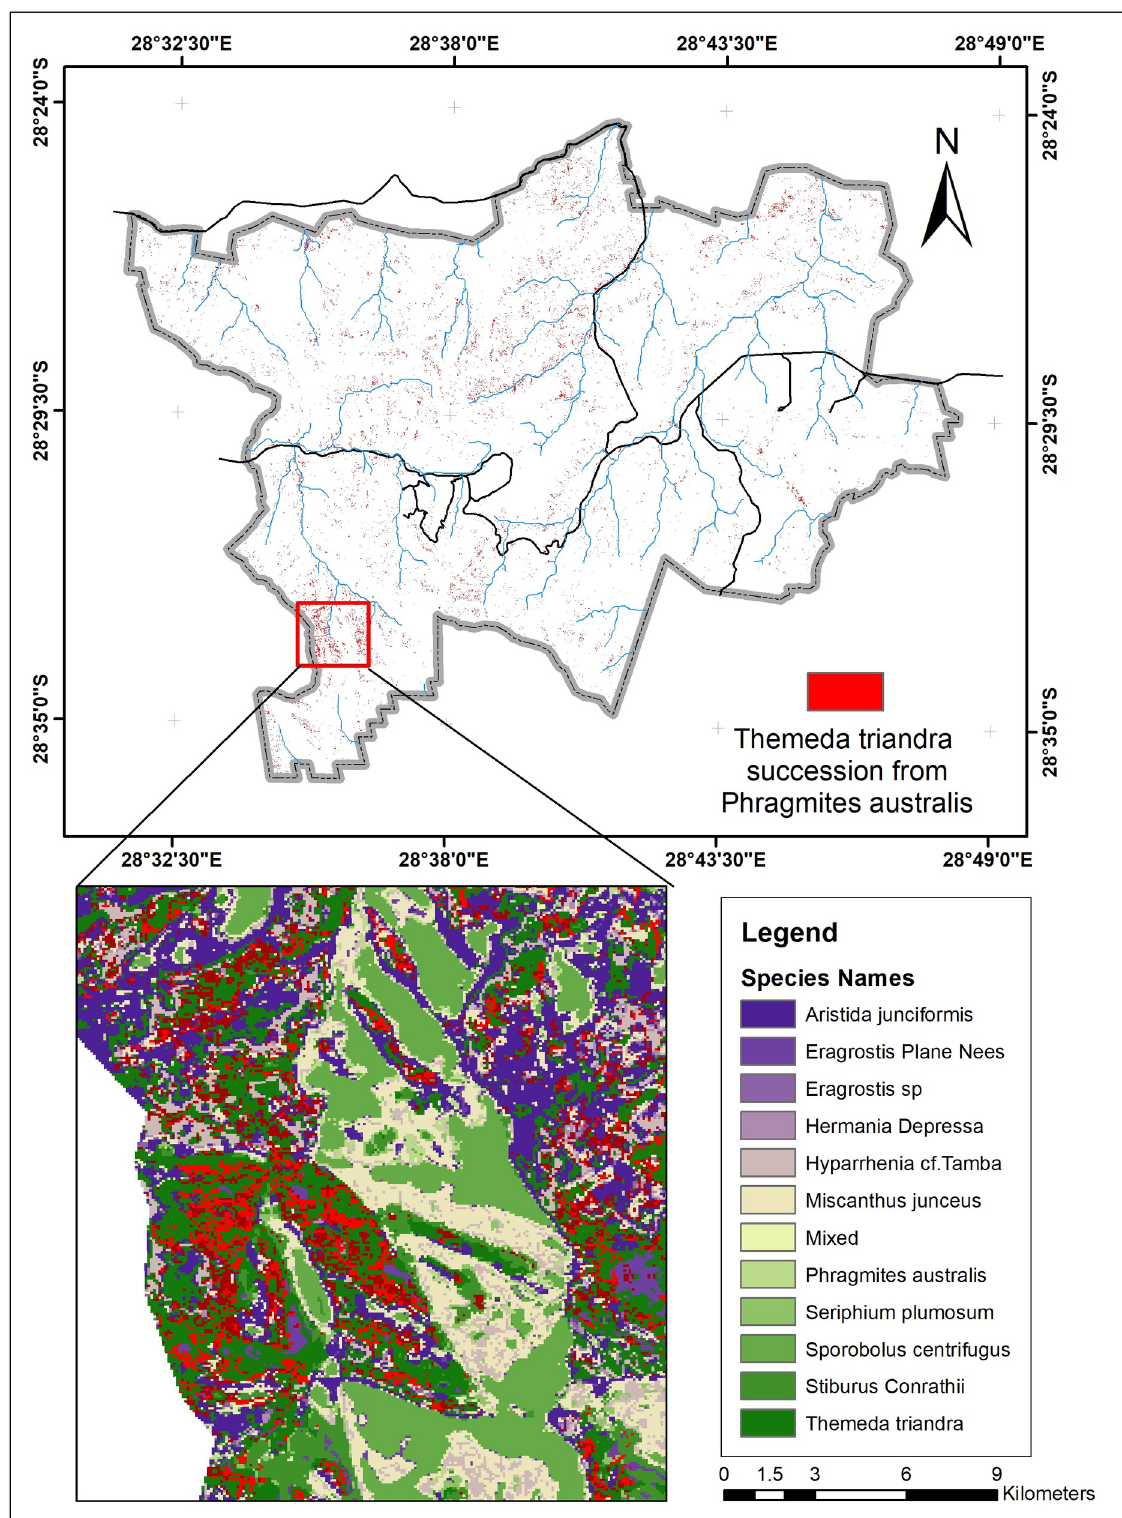
Fig 12. Areas where T . triandra succeeded from P . australis